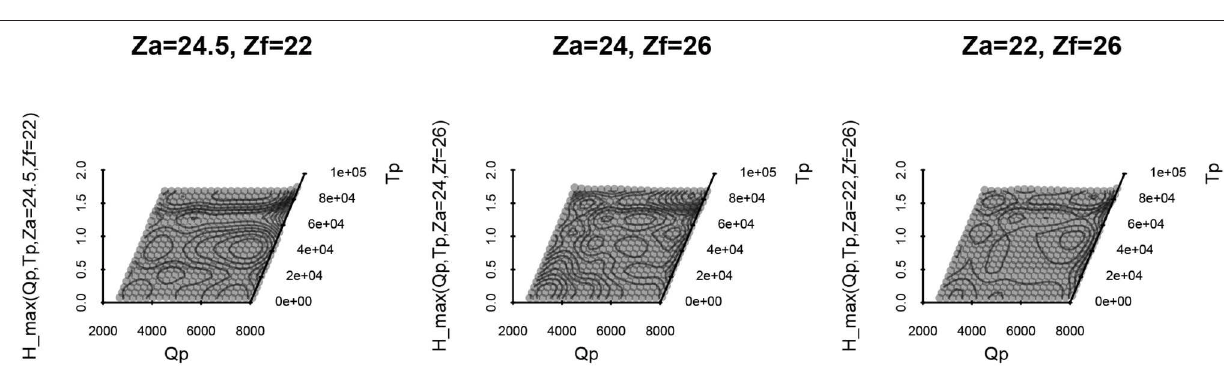
FIGURE 9 | Metamodel mean response surface on S u for surely safe